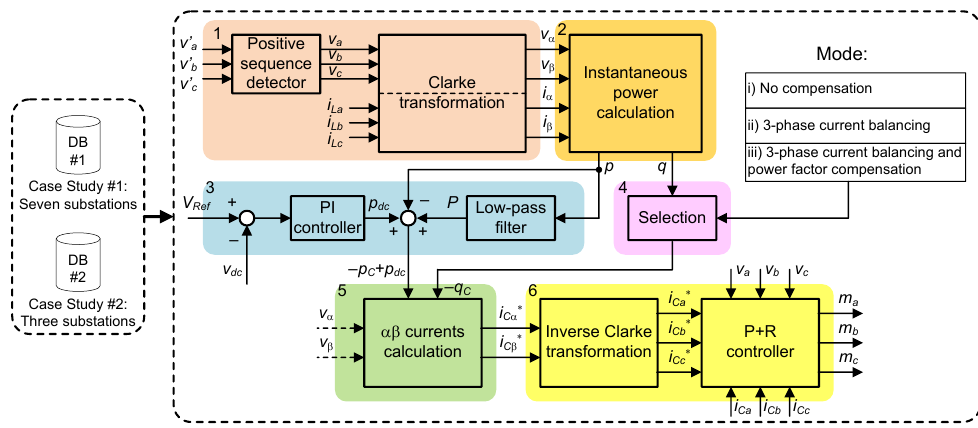
Figure 3. Control diagram of the Balancer